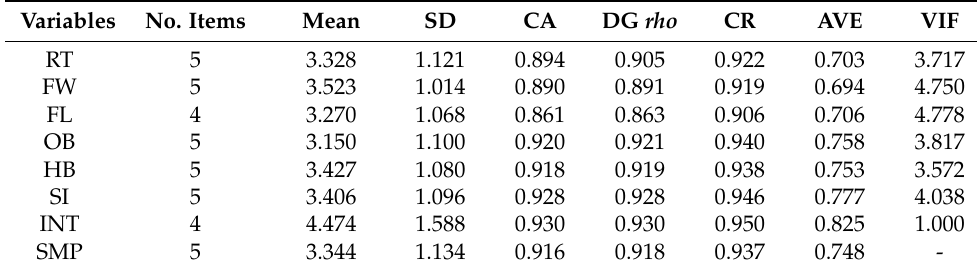
Table 2. Reliability and Validity.